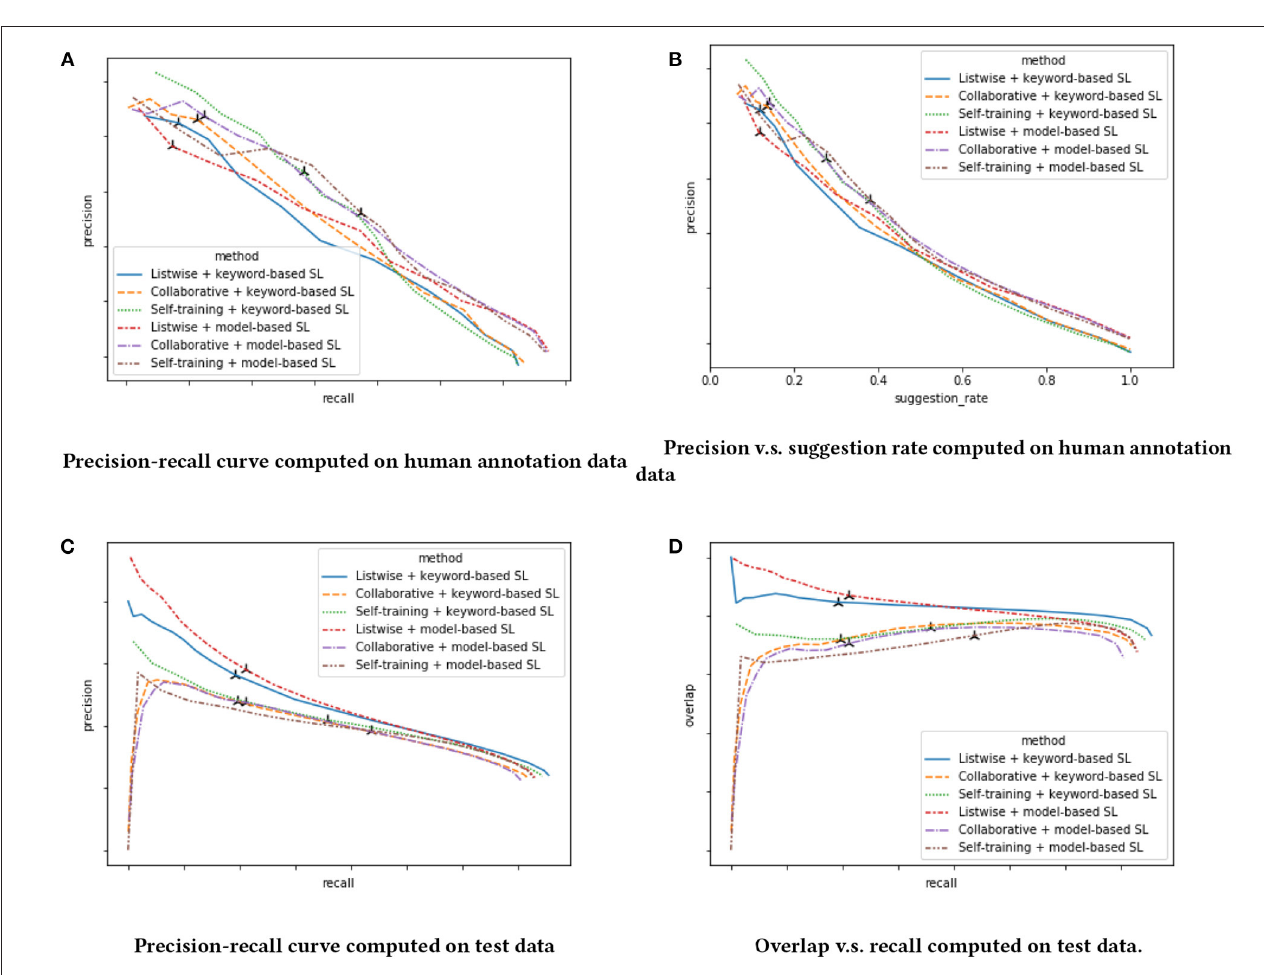
FIGURE 4 | Model performance of reranker model. The model’s metrics with cutoff point 0.5 is masked. (A) Precision-recall curve computed on human annotation data. (B) Precision vs. suggestion rate computed on human annotation data. (C) Precision-recall curve computed on test data. (D) Overlap vs. recall computed on test